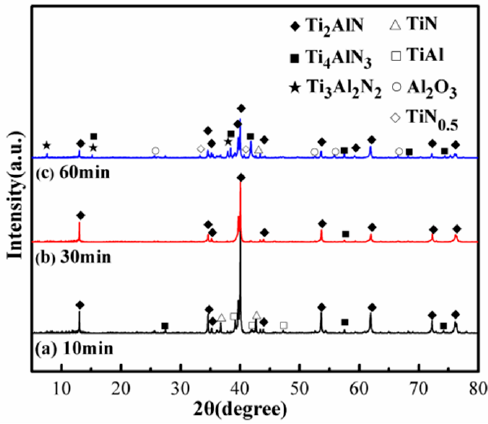
Figure 4. XRD patterns of the 1TiH 2 /1.15Al/TiN powder mixture sintered at 1250 °C for ( a ) 10 min; ( b ) 30 min; and ( c ) 60 min.